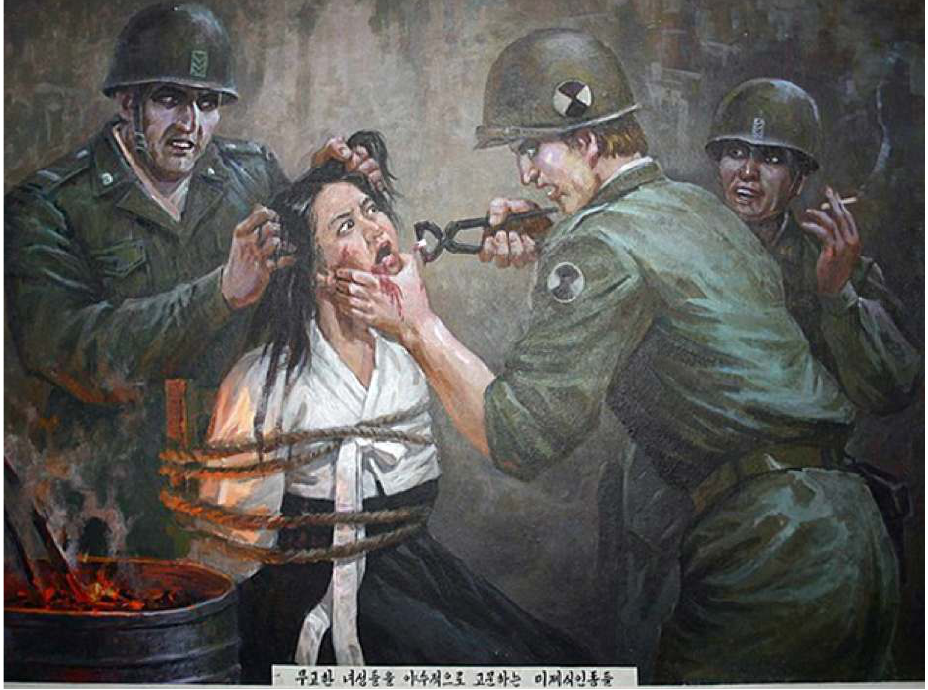
Figure 5. Sinchon Massacre, Sinchon Museum of American War Atrocities, North Korea